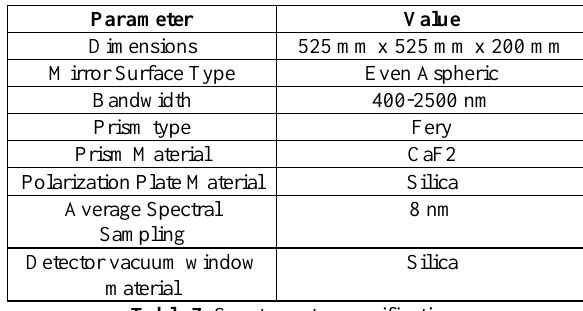
Table 7. Spectrometer specifications